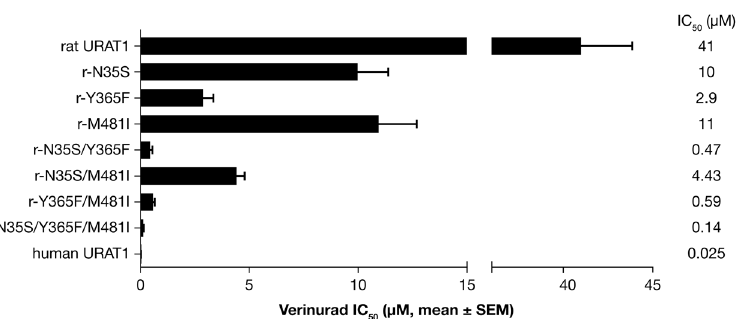
Figure 4. Human URAT1 residues 35, 365 and 481 cooperate to increase affinity for verinurad. Potency of verinurad against rat URAT1, individual or combination chimeric point mutants with human URAT1 residues at positions 35, 365 and 481, and human URAT1. Dose-response experiments were performed as in Fig. 3, and results are the mean ± SEM from at least three